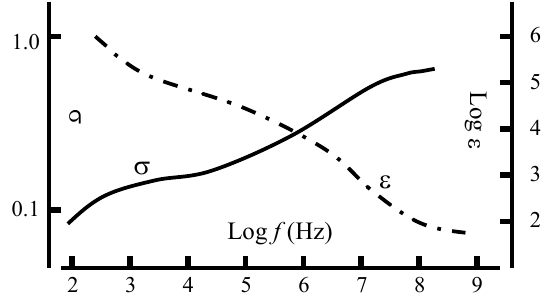
Figure 1 : A schematic of the β -dispersion exhibited by fresh tissues and compacted viable cells (derived from Schwan [4]). As the frequency is increased from ~1 kHz to 100 MHz, this dispersion is characterised by about a five-fold increase of conductivity, and around three orders of magnitude decrease of permittivity ε